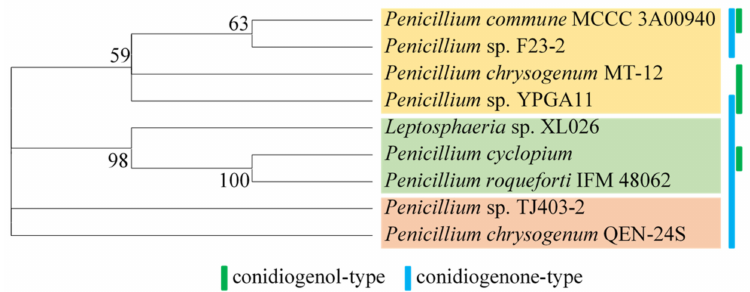
Figure 2. The evolutionary analysis tree constructed with selected fungi producing cyclopiane diterpenoids. The evolutionary analysis was reconstructed by the maximum likelihood method from the ITS sequences as follows: Penicillium commune MCCC 3A00940 (KY978585.1), P. sp. F23-2 (EU770318.1), P. sp. YPGA11 (MG835908.1), P. sp. TJ403-2 (MK613138.1), P. chrysogenum MT-12 (MF765611.1), P. chrysogenum QEN-24S (GU985086.1), P. roqueforti IFM 48062 (AB041202.1), and Leptosphaeria sp. XL026 (MK603060.1). Since the ITS sequence of strain P. cyclopium IMI 229034 was not available, P. cyclopium IFM 41611 (AB041169.1) was selected, since it was in the same family as P. cyclopium . The evolutionary analysis was conducted in MEGA X (version 10.2.2) [64].